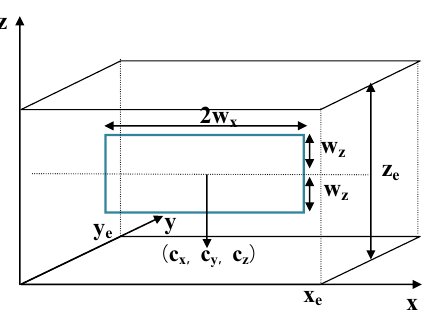
Fig. 2 Single fracture schematic of section